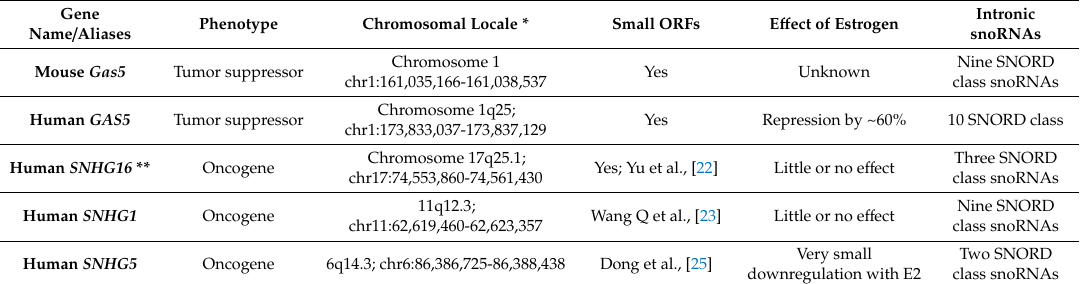
Table 1. Characteristics of the mouse growth-arrest-specific (Gas)5 and human GAS5 genes and three other human genes ( SNHG1 , SNHG5, and SNHG16 ) that also feature small nucleolar RNAs (snoRNAs) embedded in their